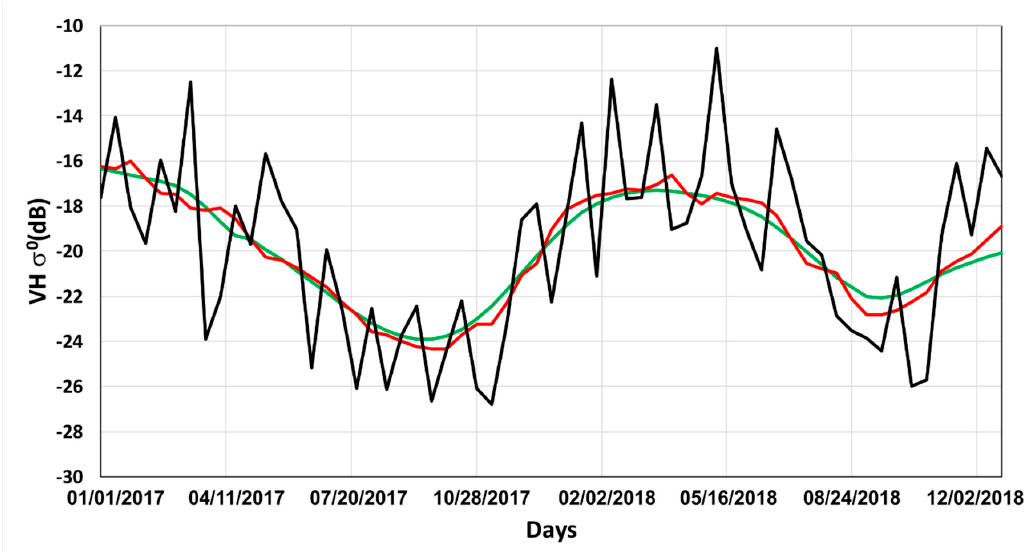
Figure 7. Effect of noise elimination in rice crop temporal trajectory using a 3D convolutional window in the spatial direction “x” and “y” and the temporal direction “t” (x = 5, y = 5, t = 9) and a second smoothing filter using the Savitzky and Golay (S-G) method. The original data is in black, 3D Gamma filter in red, and smoothing with S-G method in green.